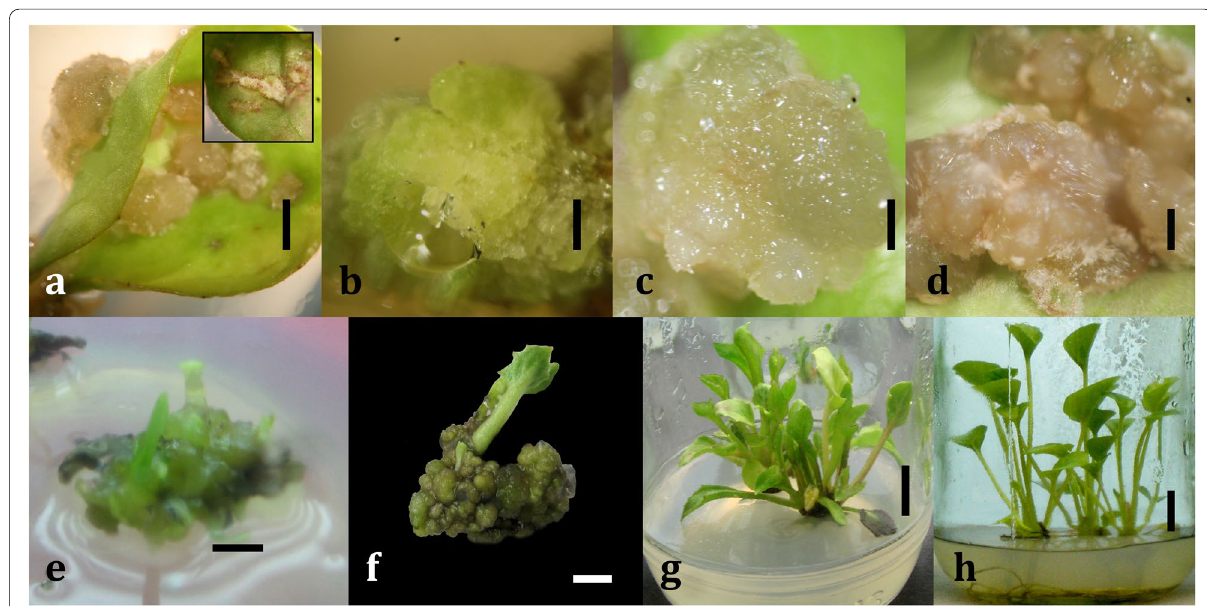
Fig. 1 Influence of sources and concentrations of plant growth regulators on callus induction and subsequent indirect plantlet regeneration of gerbera. a Induction of callus formation in the form of swelling of the injured sections of leaf due to cellular expansion ( bar 5 mm) [ inset: the = injured sections on leaf]; b proliferation of organogenic callus (induced from MS 1 mg/l picloram) ( bar 5 mm); c proliferation of embryogenic + = callus (induced from MS 1 mg/l 2,4-D) ( bar 5 mm); d proliferation and subsequent necrosis of callus (induced from MS 1 mg/l NAA) ( bar + = + 3 mm); e initiation of shoot primordia from nodular callus (induced from MS 1 mg/l picloram) in MS 1.5 mg/l kinetin ( bar 10 mm); f = + + = subsequent elongation of regenerated shoots ( bar 10 mm); g elongation, multiplication, and proliferation of regenerated shoots ( bar 25 mm); = = h root initiation and elongation from regenerated and isolated shoots in MS